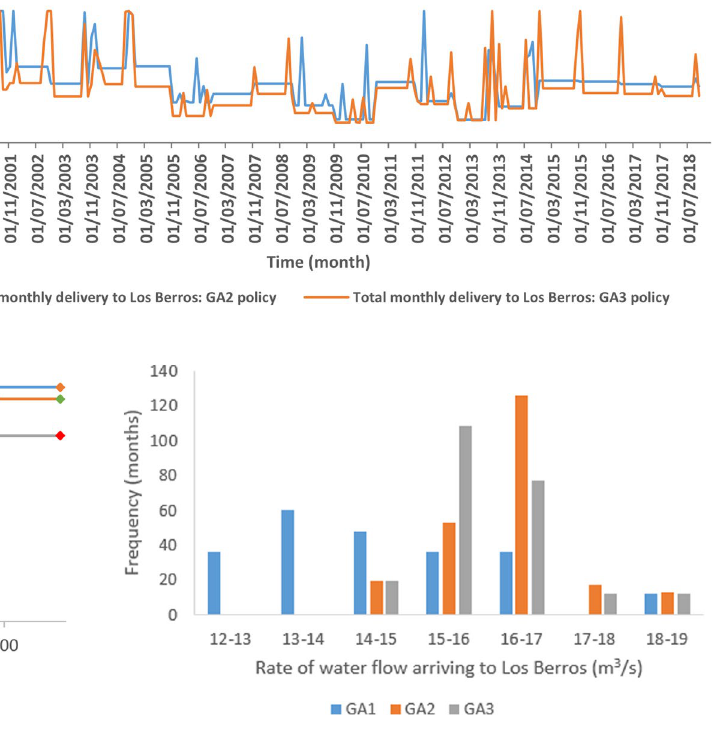
Fig. 24 Histogram showing the frequency of distinct rates of water flow to the Los Berros plant under the policies of genetic algorithm (GA)1, GA2 and